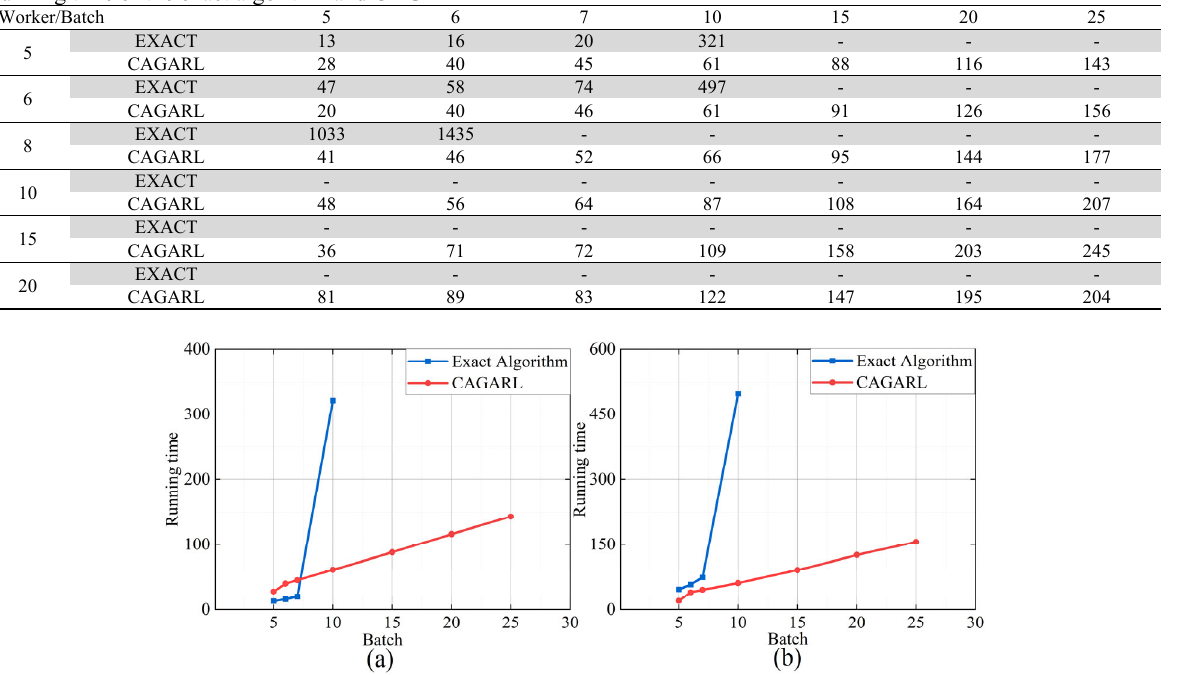
Running time of the exact algorithm and CAGARL